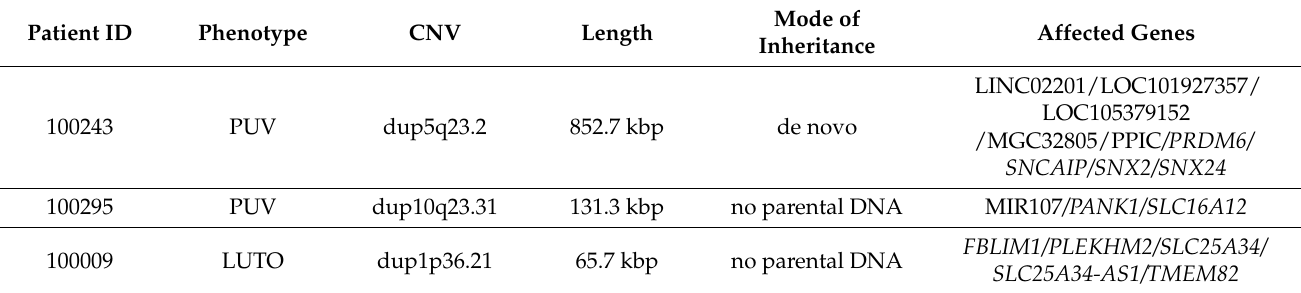
Table 1. The table presents the three validated microduplications with length, mode of inheritance and affected genes. Patient